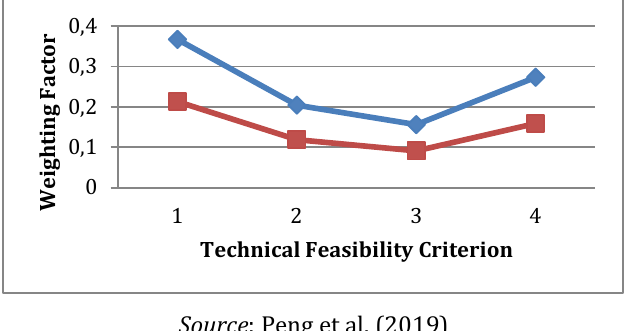
Figure 25: Variation of global and local weights of technical viability criteria